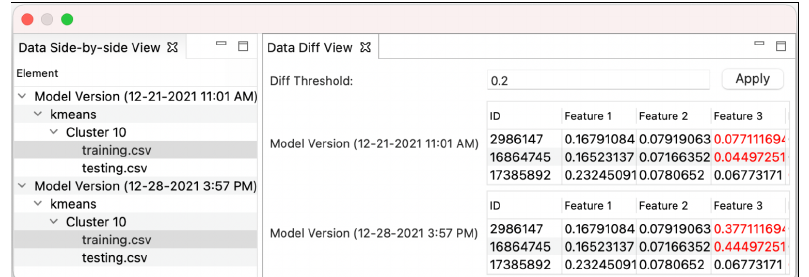
Figure 3. The tool screenshot of Data Side-by-side View and Data Diff View